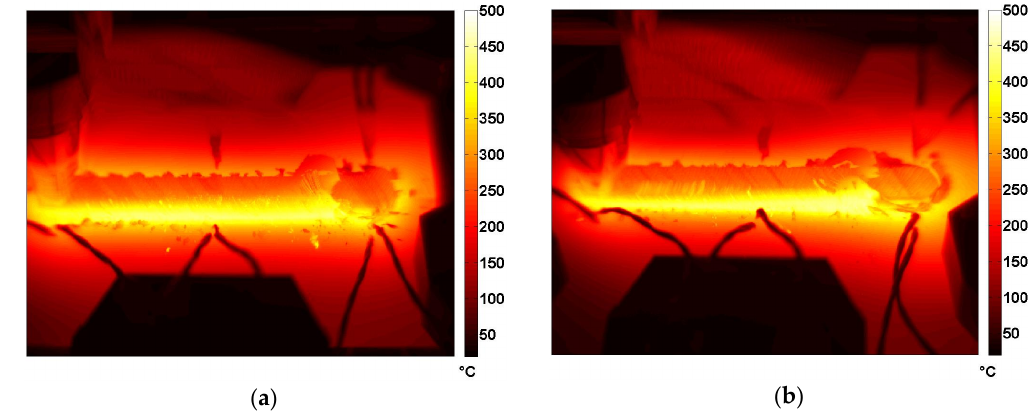
Figure 12. Maps of Tmax assessed for: ( a ) Test 1: v = 20 (cm/min) − n = 500 (RPM); and ( b ) Test 4: v = 30 (cm/min) − n = 500 (RPM).